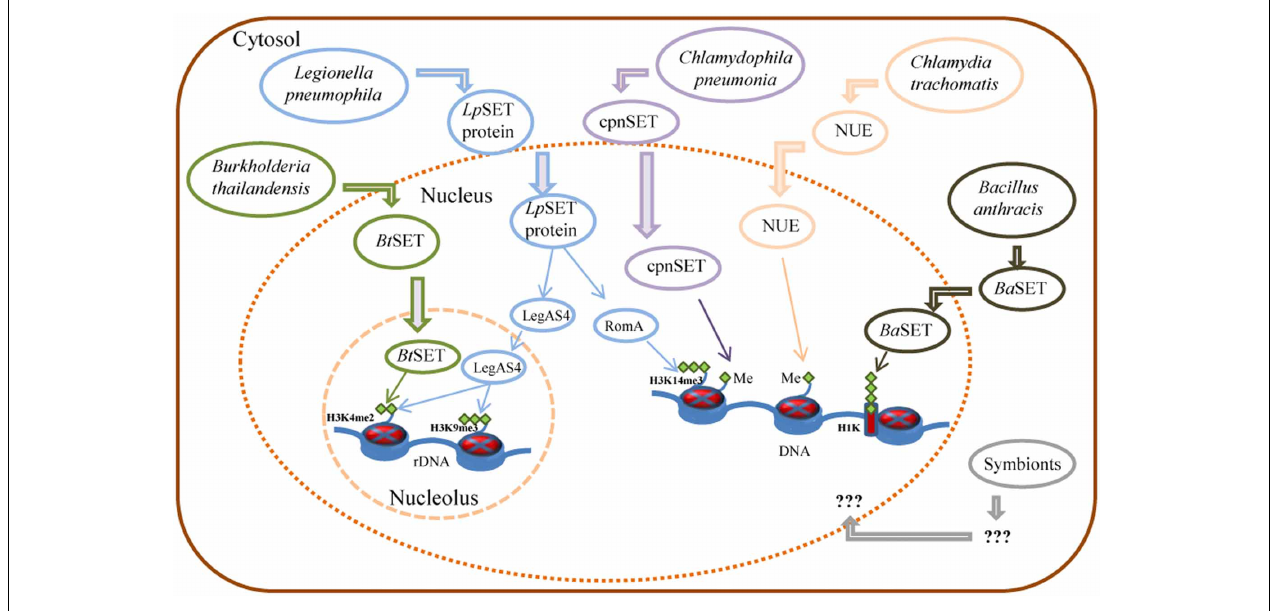
FIGURE 1 | Control of host gene expression by bacterial SET domain proteins and their mode of action. Schematic representation of Burkholderia, Legionella, Chlamydia, and Bacillus secreted factors involved in the control of gene expression of host